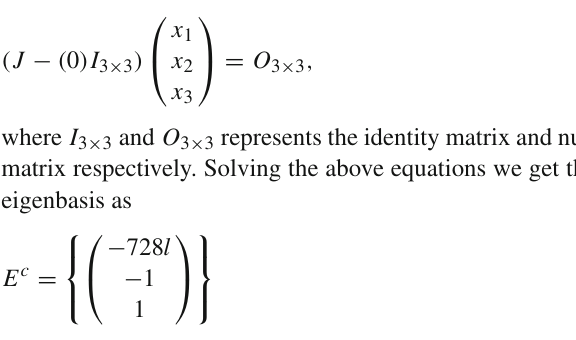
Fig. 23 The variation of η z with respect to (cid:16) at S at γ =